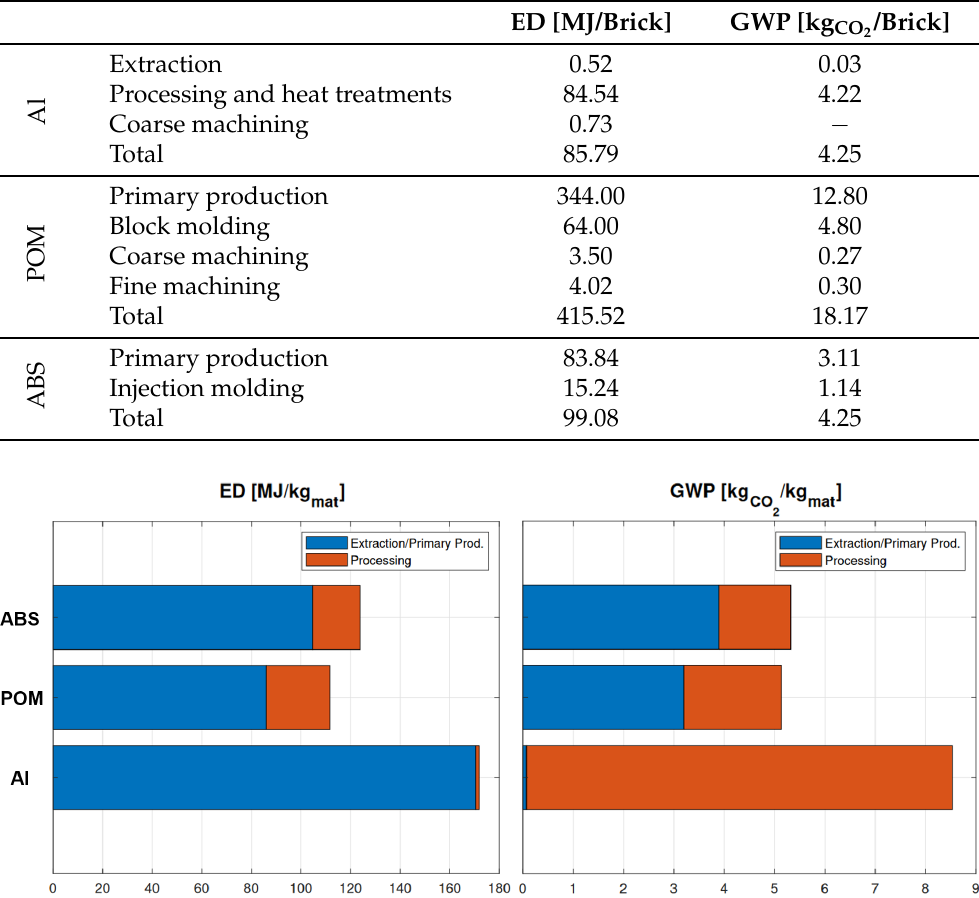
Table 1. Average ED and GWP related to the aluminum, POM, and ABS processes [67–71].